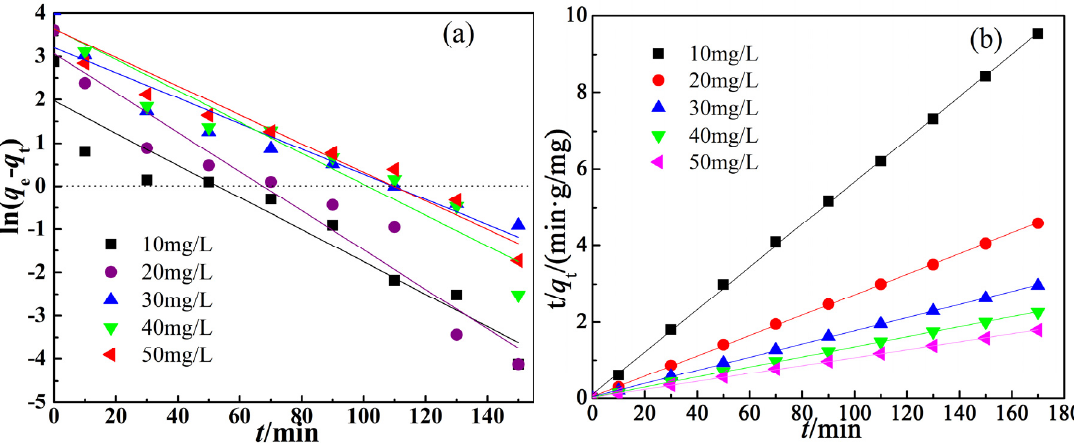
Figure 7. ( a ) Pseudo-first-order and ( b ) pseudo-second-order kinetics for adsorption of MV onto α -Fe 2 O 3 @PHCMs at different initial concentrations. Table 3. Kinetic Constants of Pseudo ‐ First ‐ Order and Pseudo ‐ Second ‐ Order Kinetic Models.